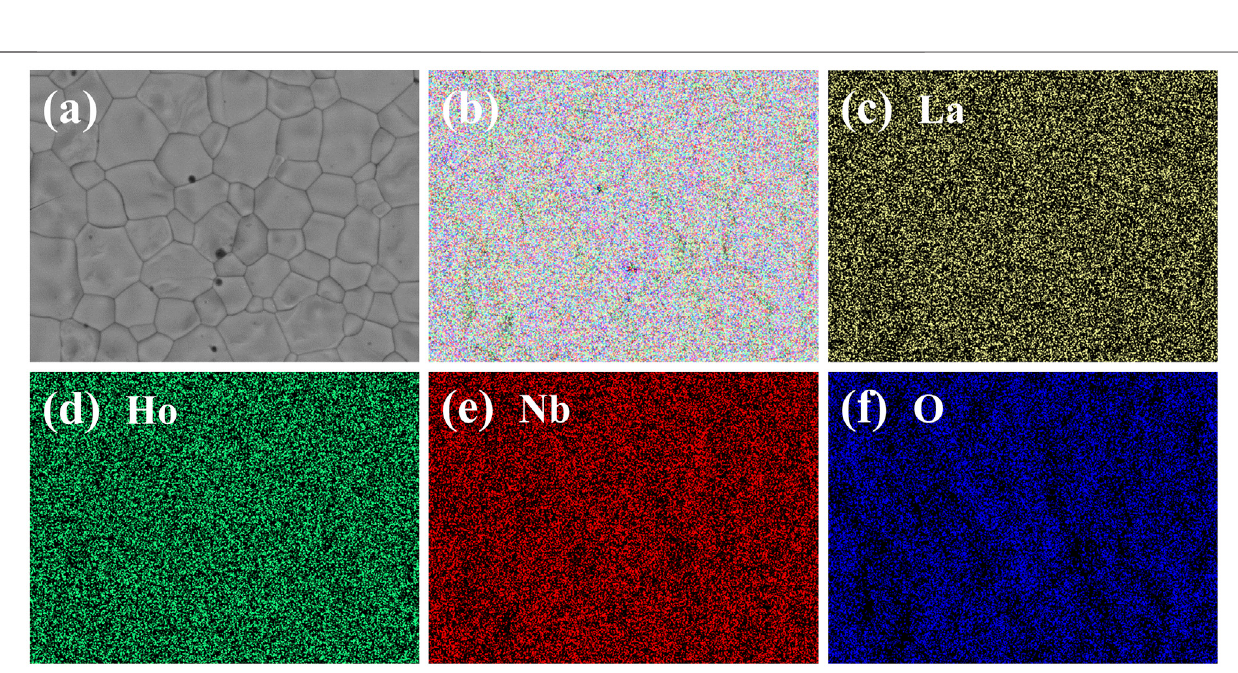
Frontiers in Materials |